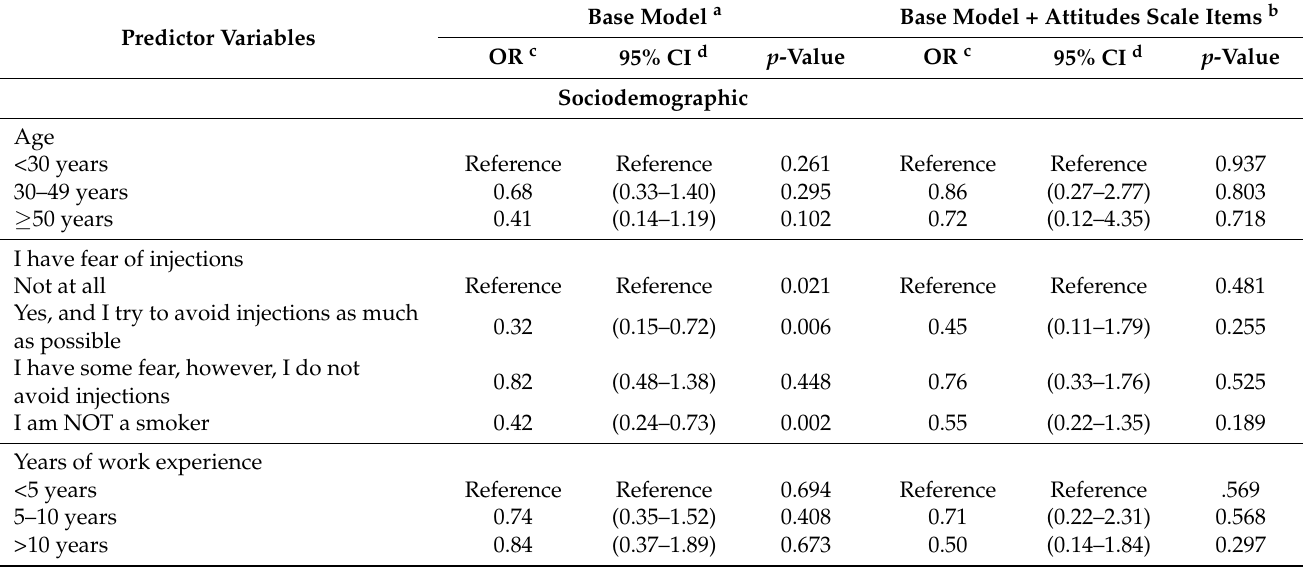
Table 3. Multivariate regression analysis: modeling factors predictive of healthcare workers’ acceptance of the COVID- 19